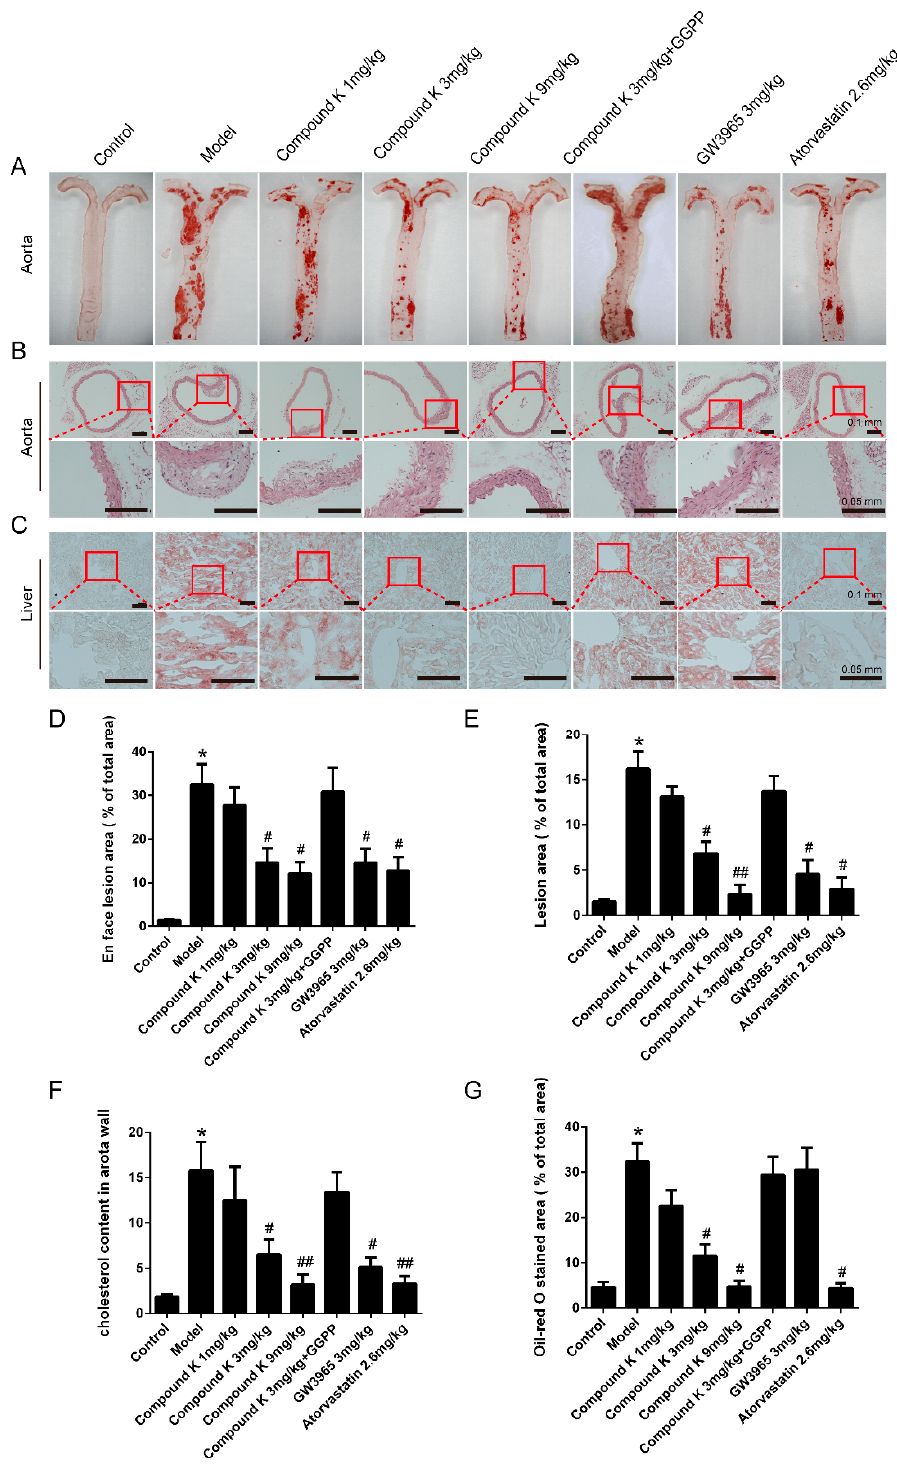
Figure 1. Compound K attenuates atherosclerosis lesion formation and fatty liver in apoE − / − mice. En face ( A ) and aortic sinus section ( B ), (zoomed areas were marked with red square) images of atherosclerosis were analysed by NIS-Elements image analysis software, and the cartograms were shown as ( D , E ). Levels of cholesterol concentration in mice aorta were extracted and measured ( F ). Levels of lipid deposition in apoE − / − mice livers were measured using Oil-Red O staining ( C ). Images of stained liver histological sections were analysed by NIS-Elements image analysis software ( G ). Data were presented as mean ± SEM ( n = 6) and analysed by ANOVA with Dunnett’s post-hoc analysis. * p < 0.05 vs. control; # p < 0.05 vs. model; ## p < 0.01 vs. model.